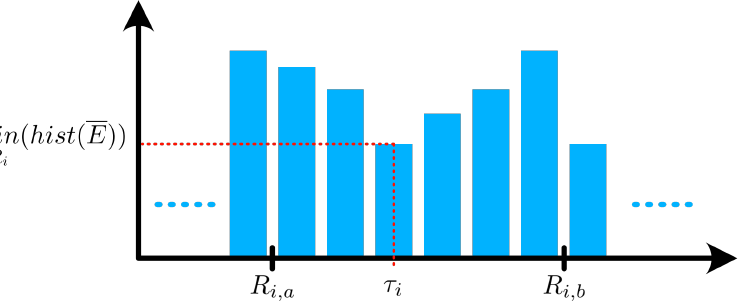
Figure 2. Illustration of how the thresholds τ i with i ∈ { 1,2,3 } are estimated for each subject, by searching for the minimum histogram count of E within the range R i .